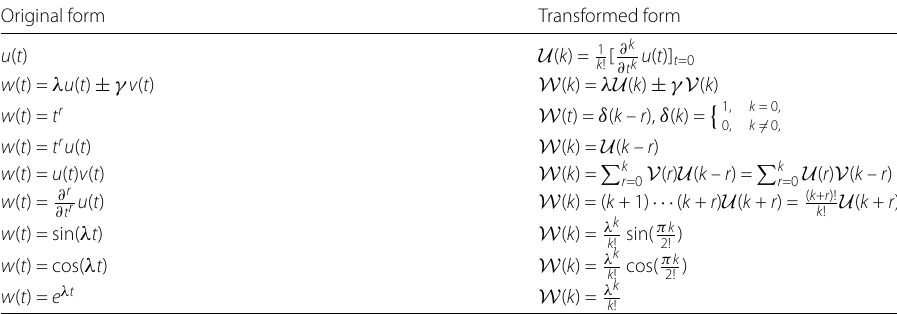
Table 1 The fundamental operations of RDTM Original form Transformed